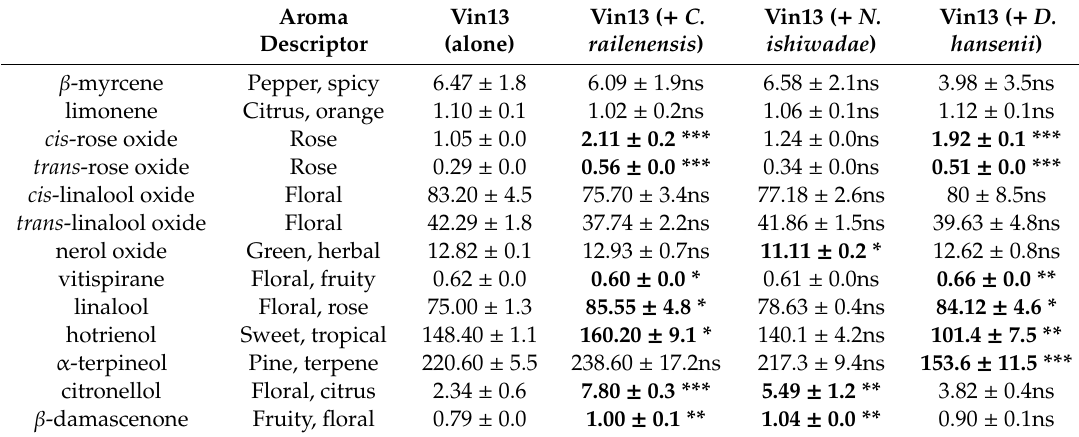
Table 2. Aroma volatiles in the final wines derived from the mixed fermentations as determined with GC-MS. Values are the average from a triplicate with the “ ± ” sign indicating the standard deviation. The compounds 2-hydroxy-4-methylvaleric acid ethylester, succinic acid diethylester, benzeneacetic acid ethylester and 2-methylbutyric acid methylester were measured during the analysis, but were not detected in any of the samples. ns not significant * p < 0.05; ** p < 0.01; *** p < 0.001. Boldface indicate significant values.